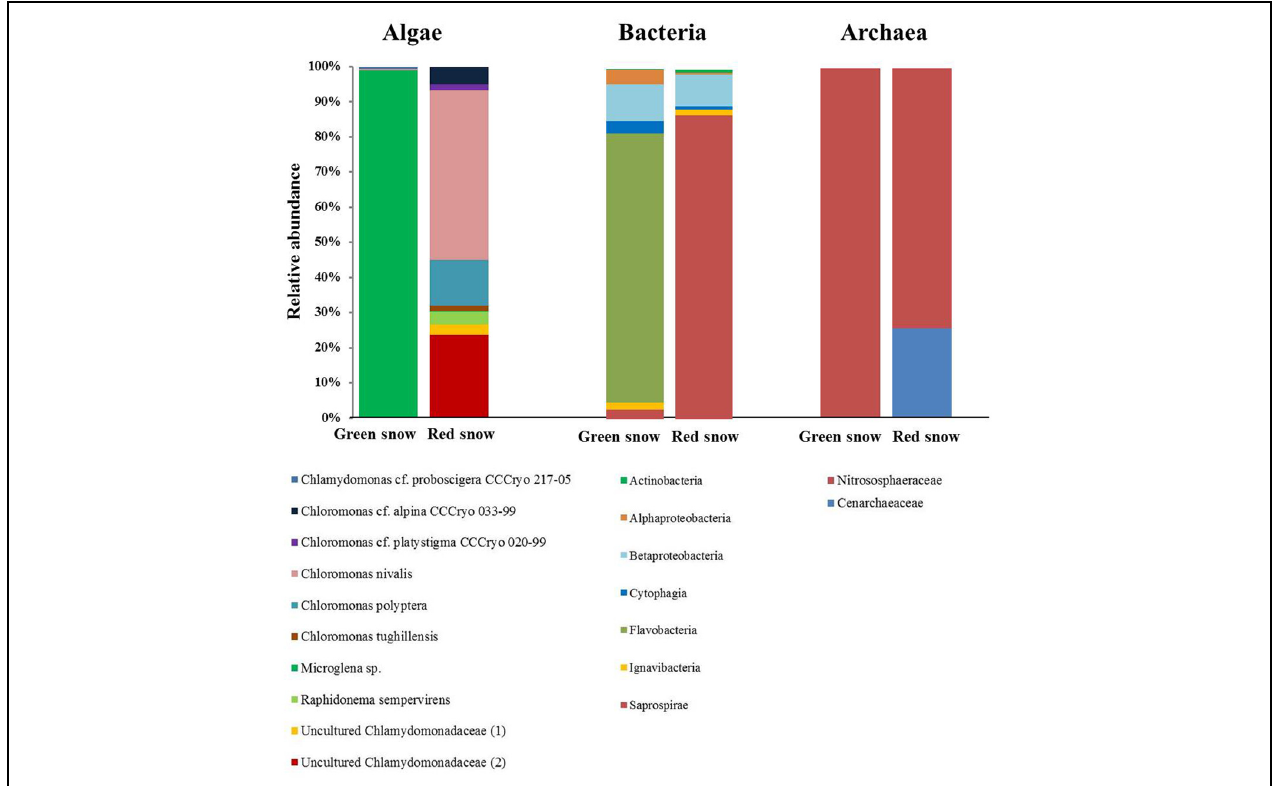
FIGURE 2 | Algal (18S rRNA), bacterial (16S rRNA), and archaeal (16S rRNA) community composition of green and red snow, derived from OTU clustering at 97%